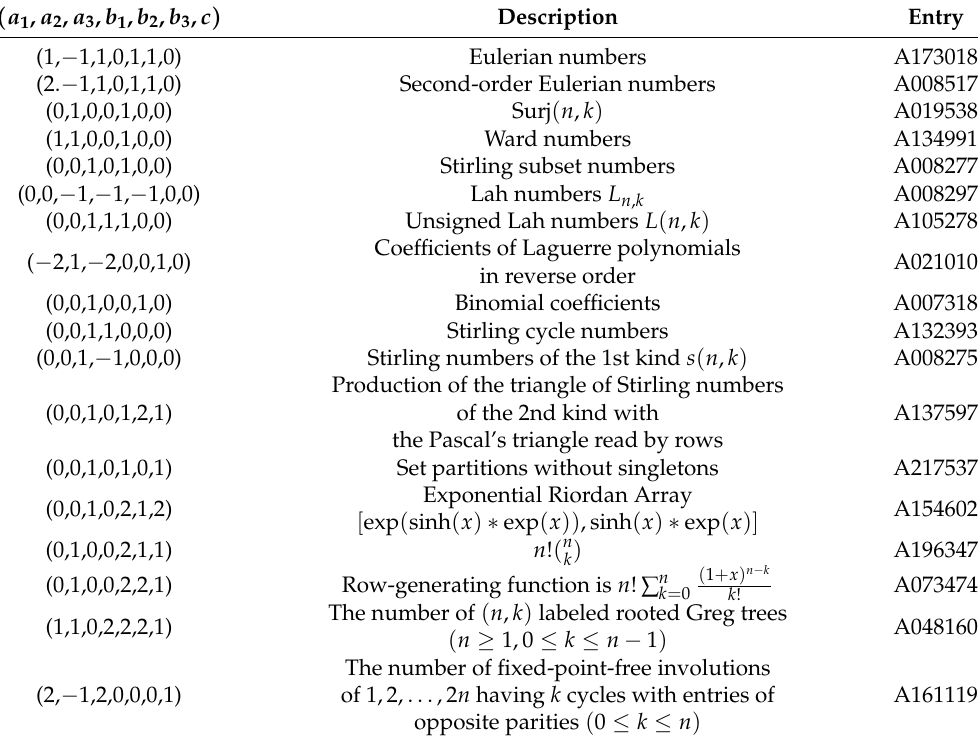
Table 1. Some combinatorial sequences satisfying formula